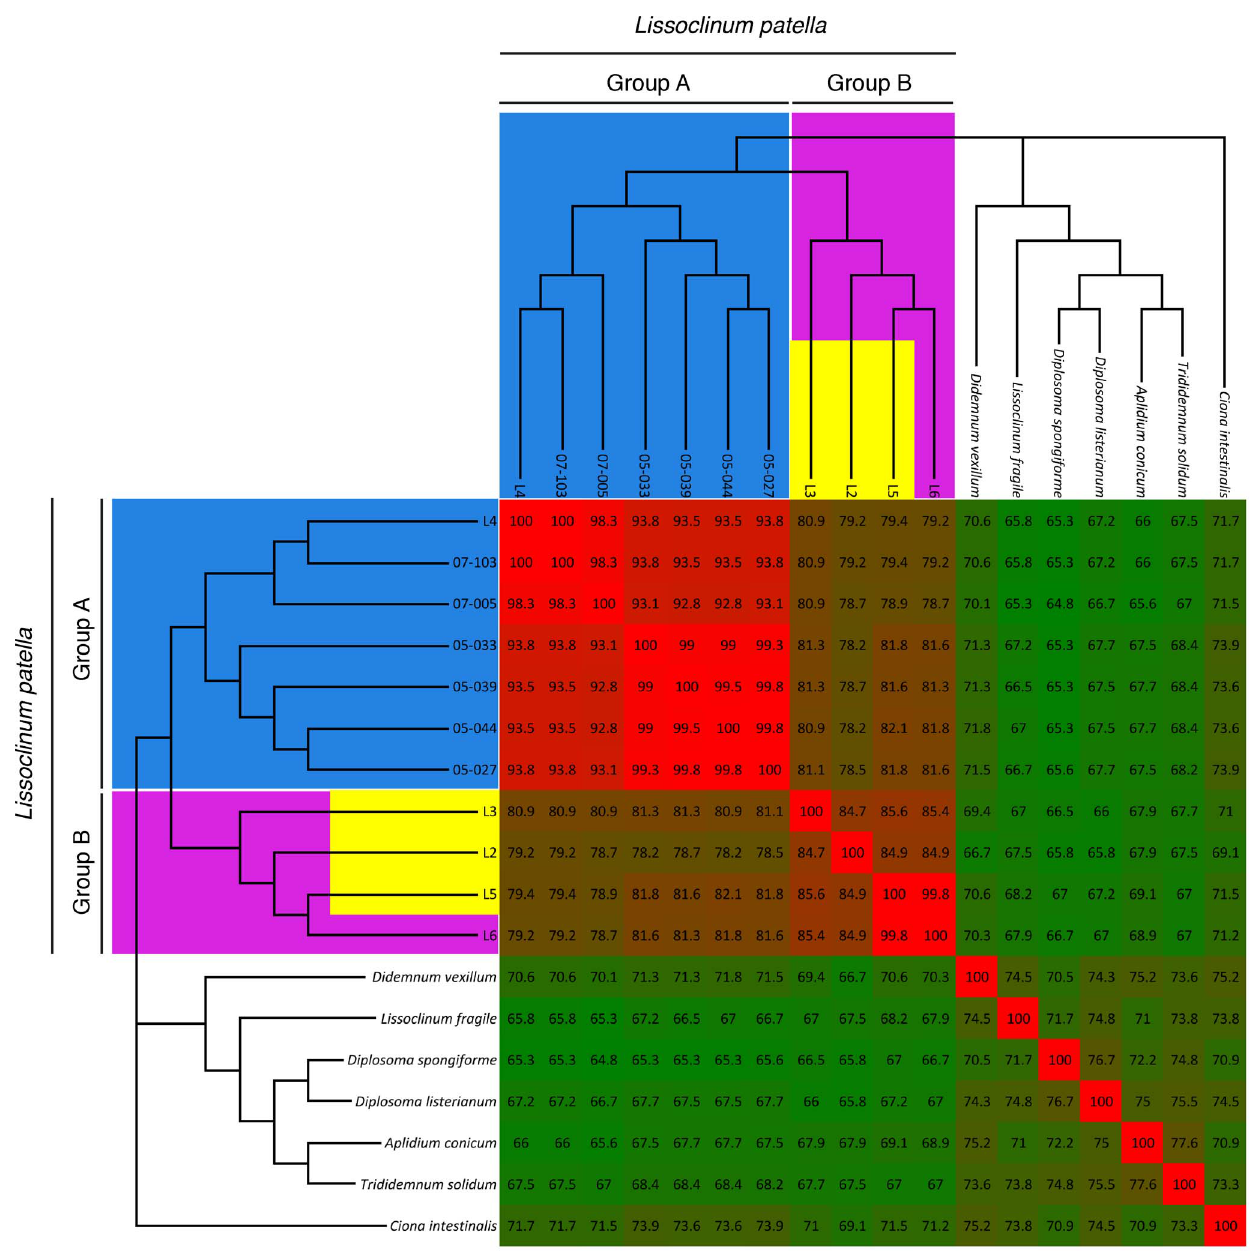
Figure 2. Patellazoles-containing L. patella animals form a distinct, divergent clade that may include several cryptic species. Cytochrome c oxidase I (COXI) gene nucleotide sequences from various L. patella animals were aligned and used to construct a phylogenetic tree. COXI sequences from other didemnid ascidians and Ciona intestinalis are included as an outgroup and for comparison, and were obtained from the NCBI database (see Materials and Methods). Animals containing patellazoles are highlighted in yellow, ‘‘Group A’’ is shown in blue and ‘‘Group B’’ is shown in magenta [13].